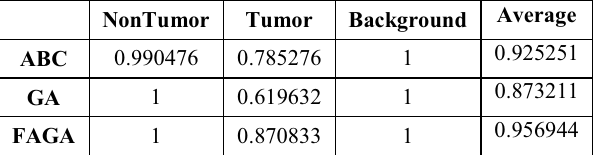
Table 4. Performance comparison using third image in terms of accuracy